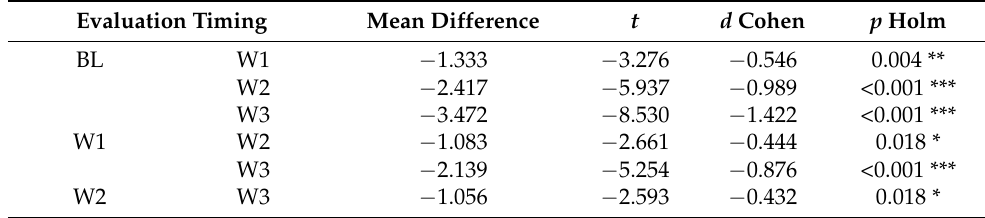
Table 6. Size effect of the programme.